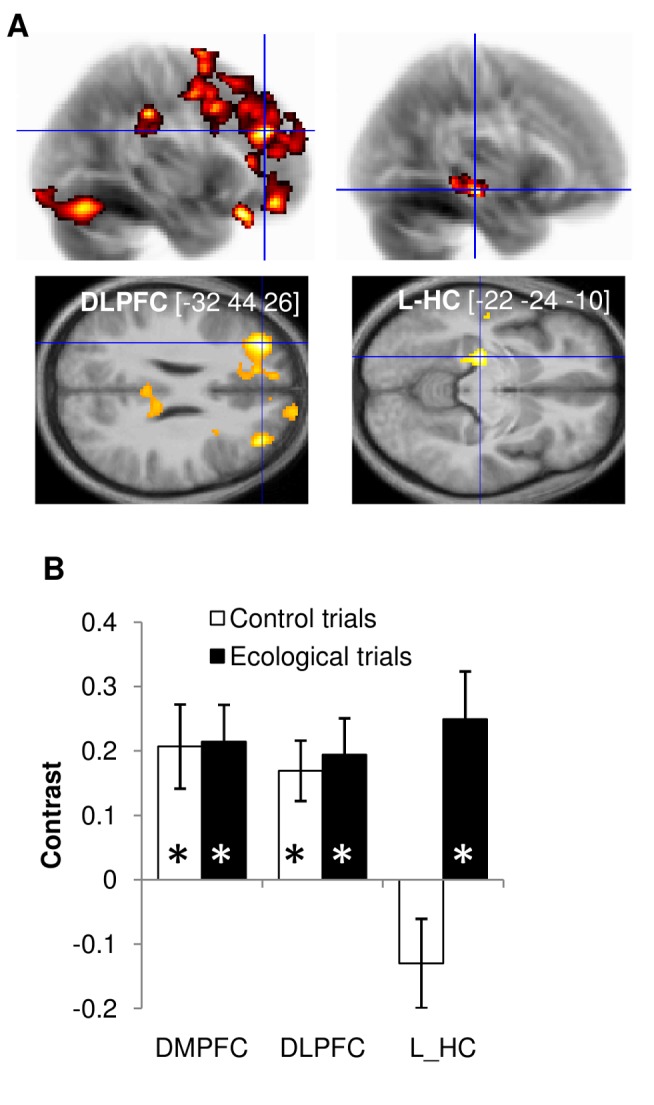
Group-level neural correlates of choices.(A) Statistical parametric maps. Left: contrast between nonimpulsive and impulsive choices including all trials, at the time of decision-making. Right: comparison of this same contrast between ecological versus control trials (i.e., Choice×Condition interaction). The color code on glass brains (top maps) and axial slices (bottom maps) indicates the statistical significance of clusters that survived the illustrative threshold (more than 200 voxels with p<0.005). The [x y z] coordinates of the different maxima refer to the Montreal Neurological Institute (MNI) space. Slices were taken in the different regions of interest (ROIs), along planes indicated by blue lines on glass brains. (B) Regression coefficients (betas). Bars indicate the contrast between nonimpulsive and impulsive choices for the ecological and control trials. The ROIs were defined as the intersection of functional activations and anatomical templates. Error bars indicate intersubject standard errors of the mean. HC, hippocampus; DLPFC, dorsolateral prefrontal cortex; DMPFC, dorsomedial prefontal cortex.